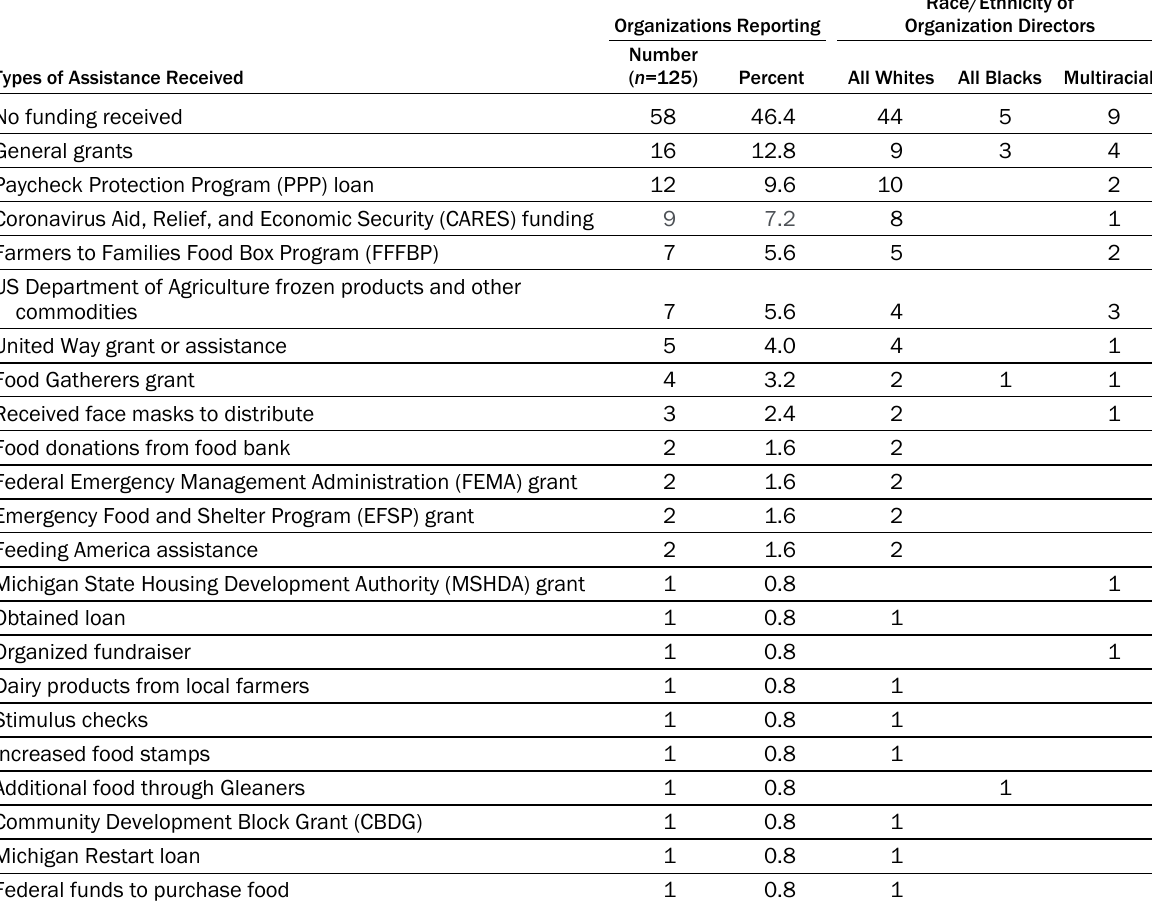
Table 8. Government Assistance that Emergency Food Assistance Organizations Received During the